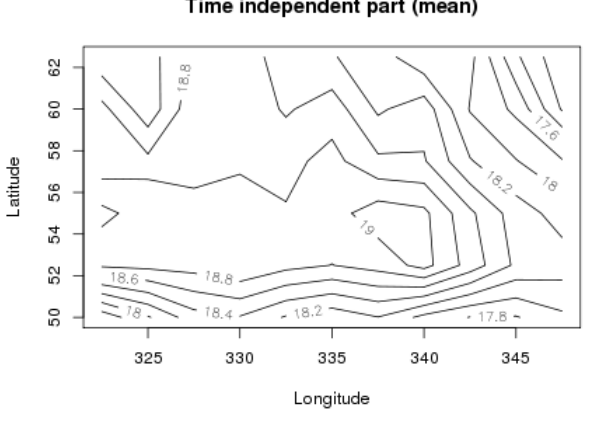
Fig. 6. The posterior mean seasonal contribution. Fig. 5. The spatial field µ(x) .